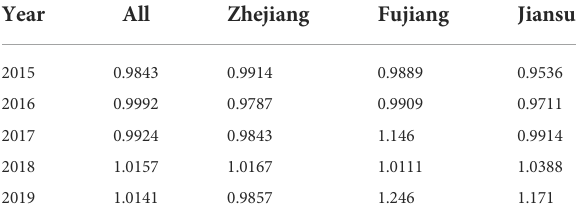
TABLE 3 Productivity changes.